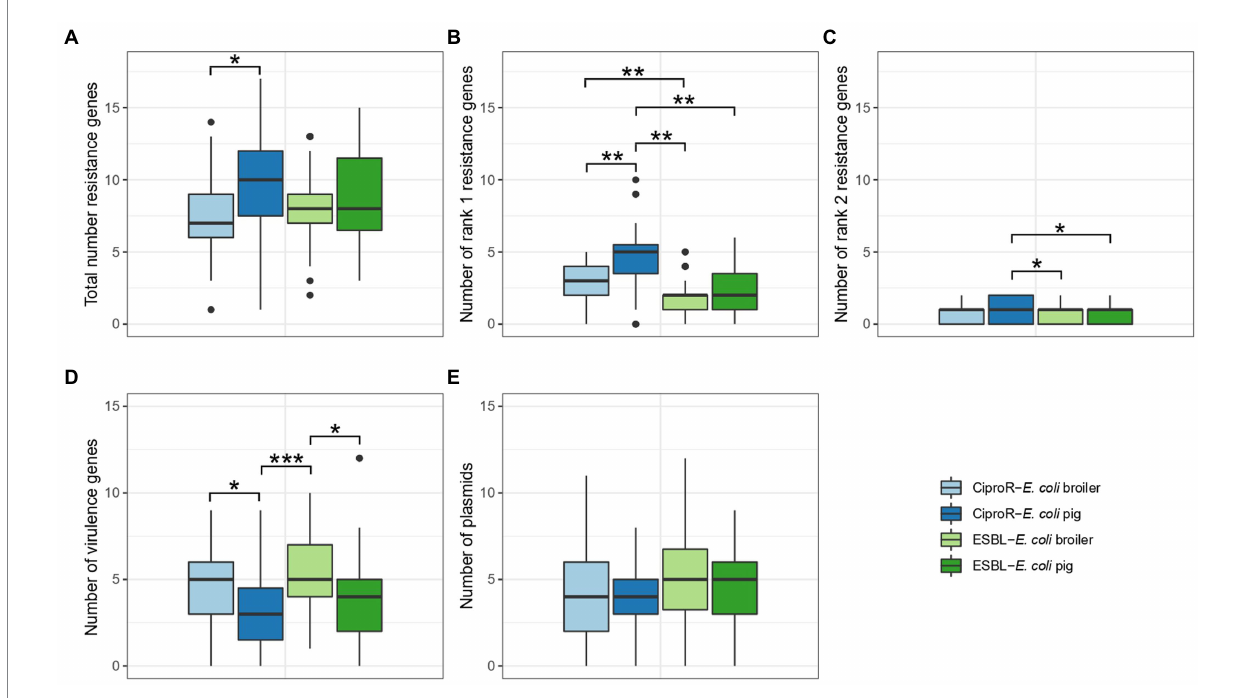
FIGURE 2 Number of resistance genes (A–C) , virulence genes (D) and plasmids (E) in ESBL- Escherichia coli and CiproR- E. coli isolated from broilers and pigs. Statistically significant differences are indicated according to the level of significance: * ( p < 0.05), ** ( p < 0.01), *** ( p < 0.001) (ANOVA with TukeyHSD or Games-Howell post-hoc